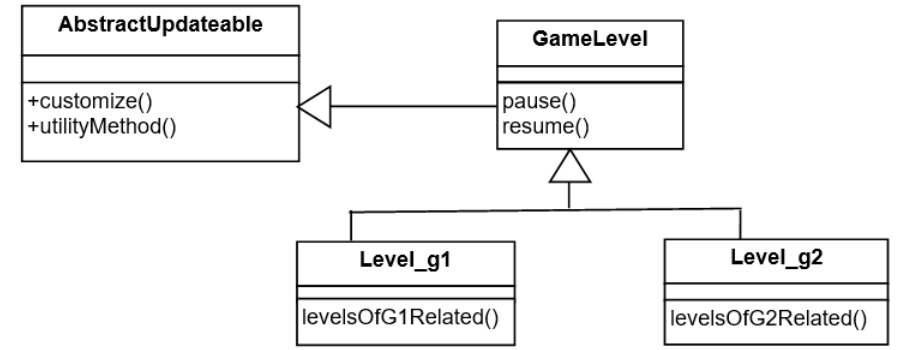
Figure 13. First alternative approach for implementing Related Levels pattern.